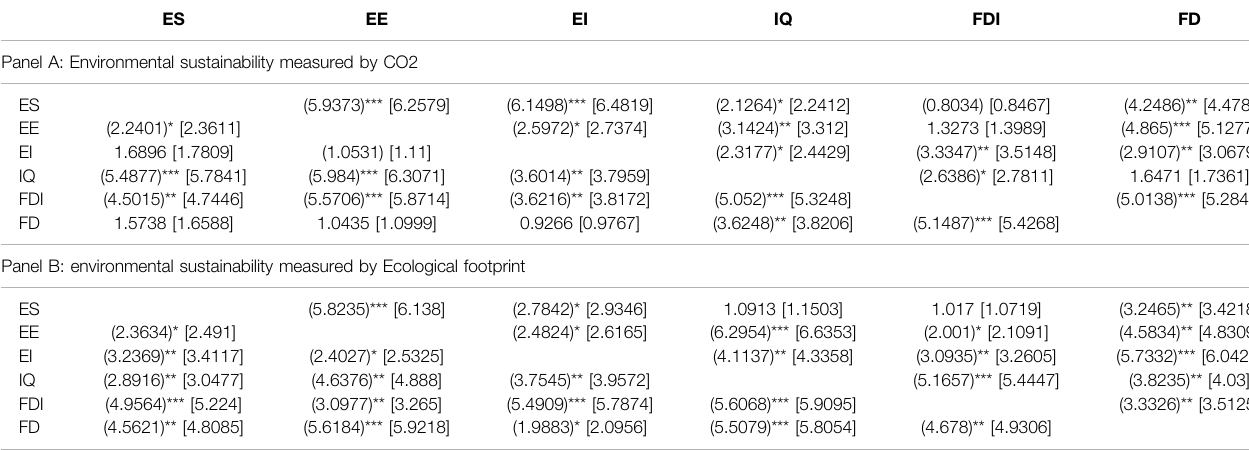
TABLE 9 | Results of causality test: EI measured by environment-related patents number. ES EE EI IQ